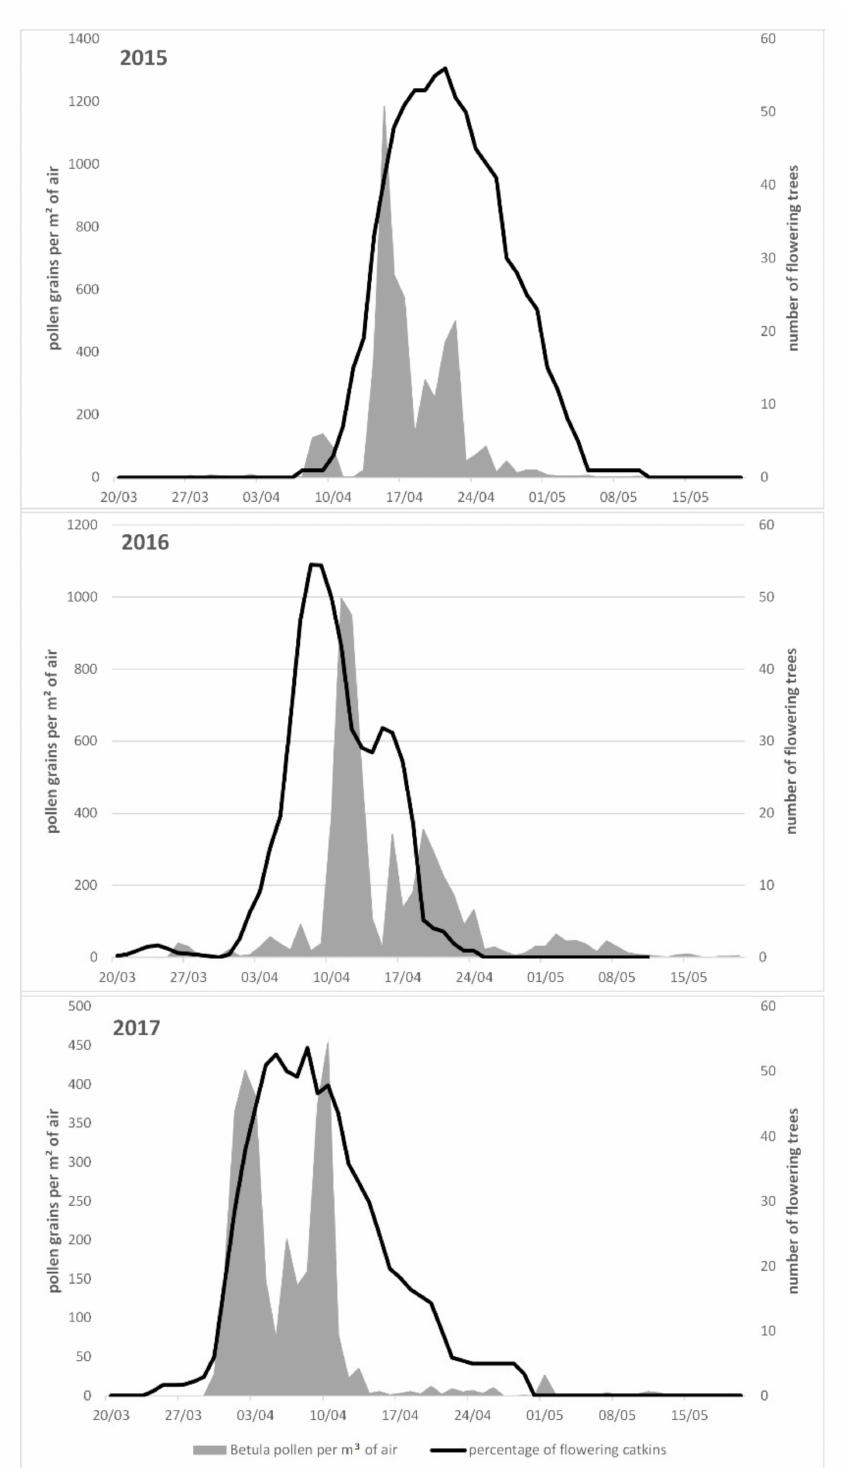
Figure 4. Seasonal patterns of pollen atmospheric circulation for Betula spp. and flowering phenology patterns for Betula pendula that is the main representative of this pollen taxon in the study area. The X axis corresponds to the observation date; the Y axis (left) corresponds to the mean percentage of open inflorescences per individual plant and the Y ’ axis (right) to the pollen atmospheric concentration (per m 3 of air). The grey area indicates airborne pollen concentrations, whereas the black line phenological observations of flowering. Based on time-series analyses (cross-correlations), all pairs of seasons significantly correlate between them ( p <